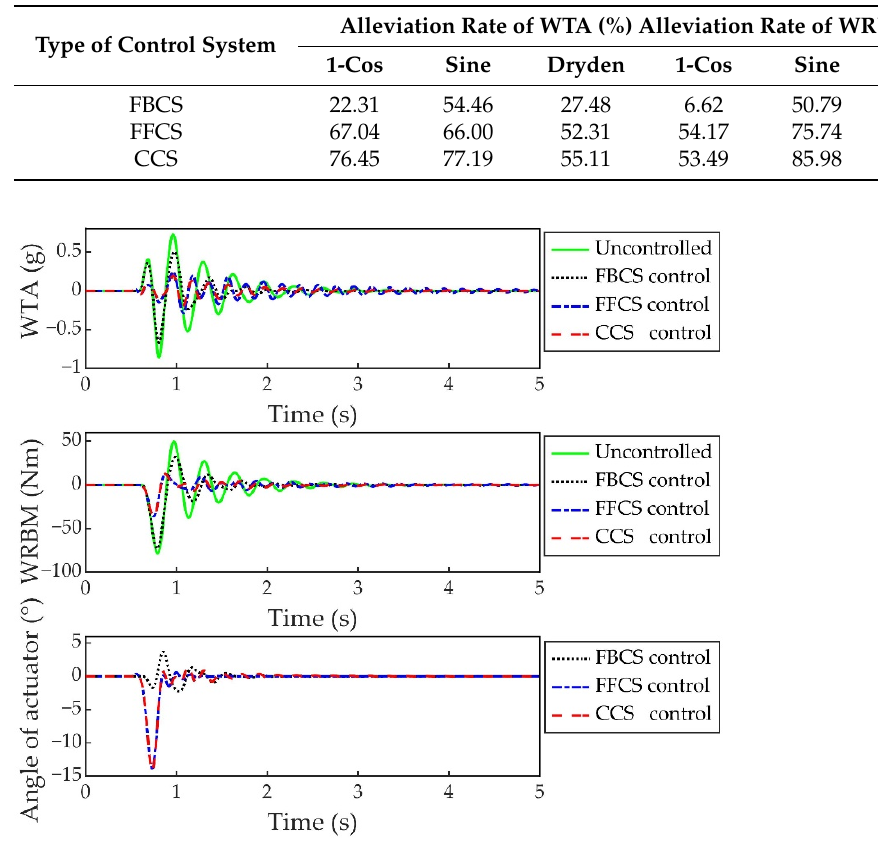
Figure 9. Comparison of gust alleviation effects of 1-cos gust.